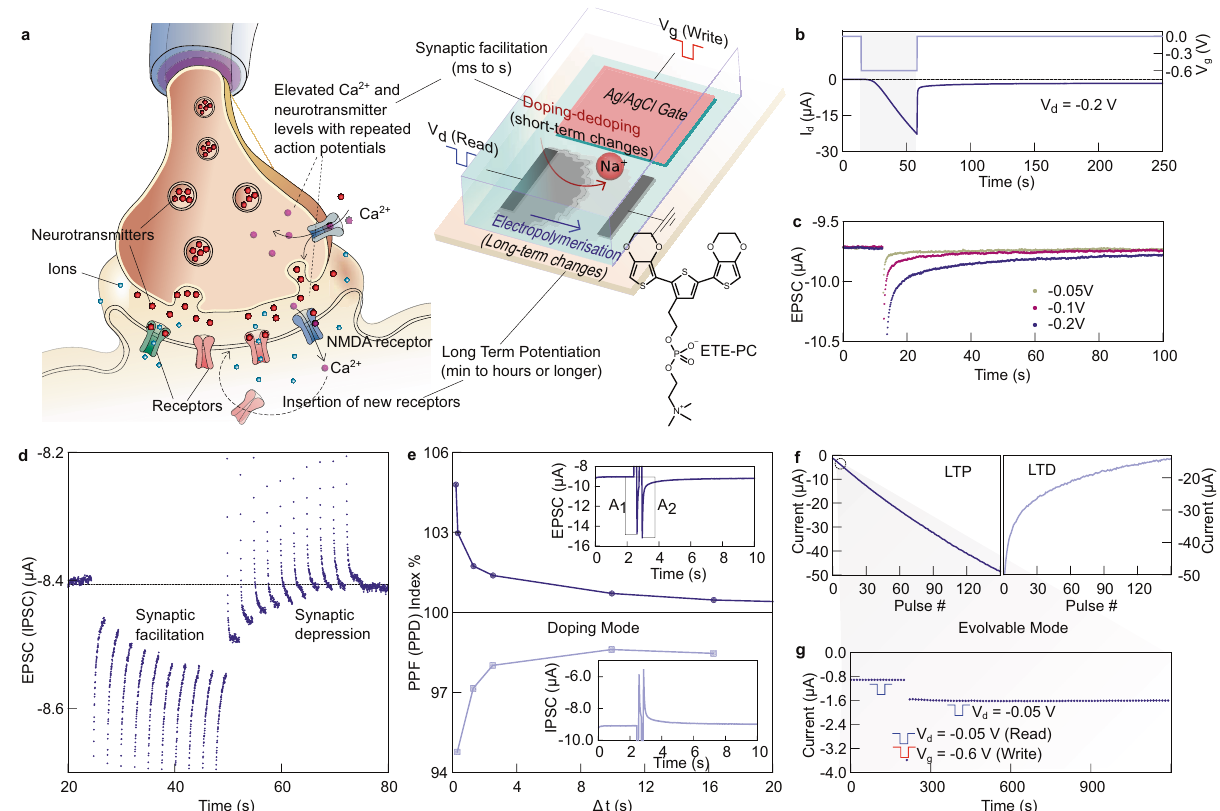
Fig. 3 Printed organic electrochemical synapses. a Schematic of the biological and printed organic electrochemical synapses showing analogy between electropolymerization and insertion of new receptors to cause long-term potentiation; and doping-dedoping process and elevation of neurotransmitter levels resulting in synaptic facilitation. The structure of the monomer ETE-PC is also shown. b Electropolymerization process to form the semiconducting channel on application of 0.6 V pulse at the gate (drain is kept at − 0.2 V and source at 0 V) and resulting increase in drain current after the pulse. c Excitatory post synaptic current measured at the drain on application of various gate pulse voltages. d Synaptic facilitation and depression with the application of − 0.1 V and + 0.02 V pulses at the gate showing accumulation of charges in the charges on successive pulses. e Paired pulse facilitation and paired pulse depression indices of the synapse operating in the short-term doping-dedoping mode. f Long-term potentiation and depression (LTP and LTD) achieved by stepwise electropolymerization ( − 0.6 V, 1 s pulses) and overoxidation ( − 2 V, 1 s pulses) of the channel. g Long term stability of a single state on electropolymerization showing retention times > 1000 s. The write pulse is − 0.6 V (1 s) on the gate and read pulses are − 0.05 V (1 s) on the drain applied every 20 s to measure state